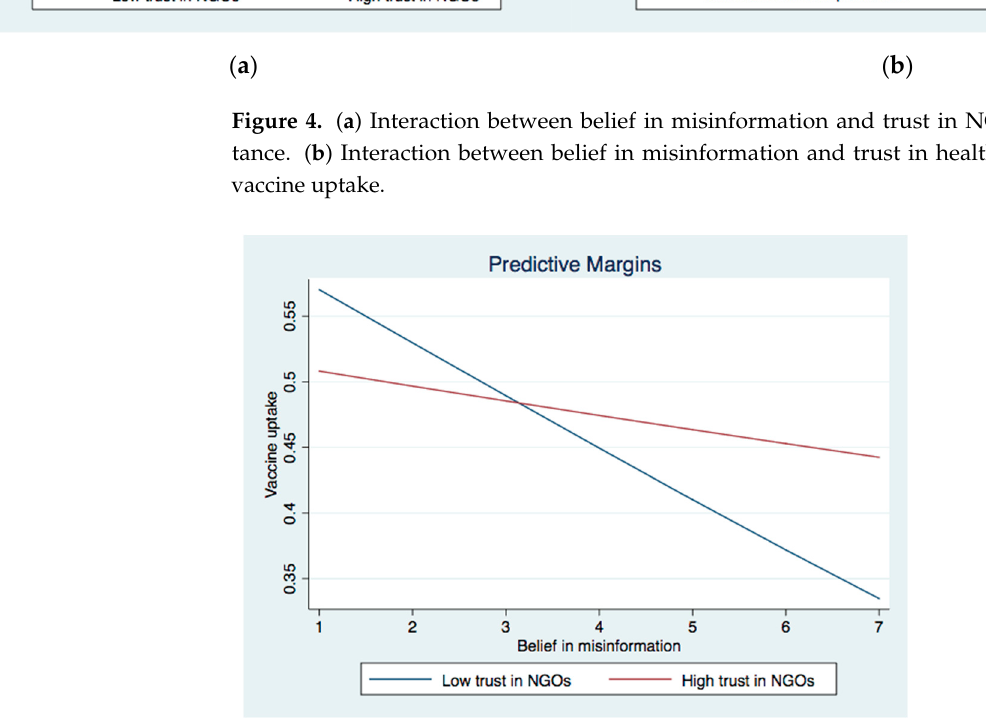
Figure 5. Interaction between belief in misinformation and trust in NGOs on vaccine uptake.